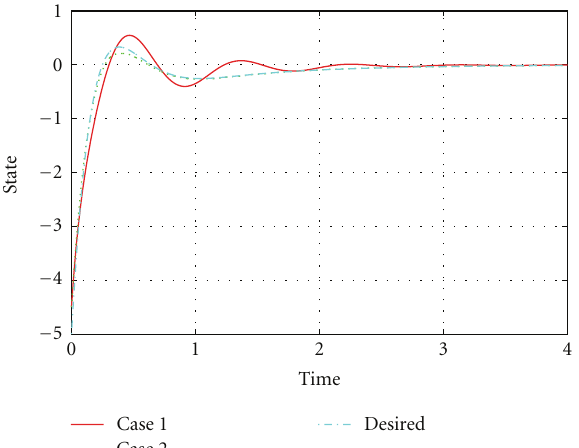
Figure 5: Time histories of the adjustable parameter (cid:8) θ ( t